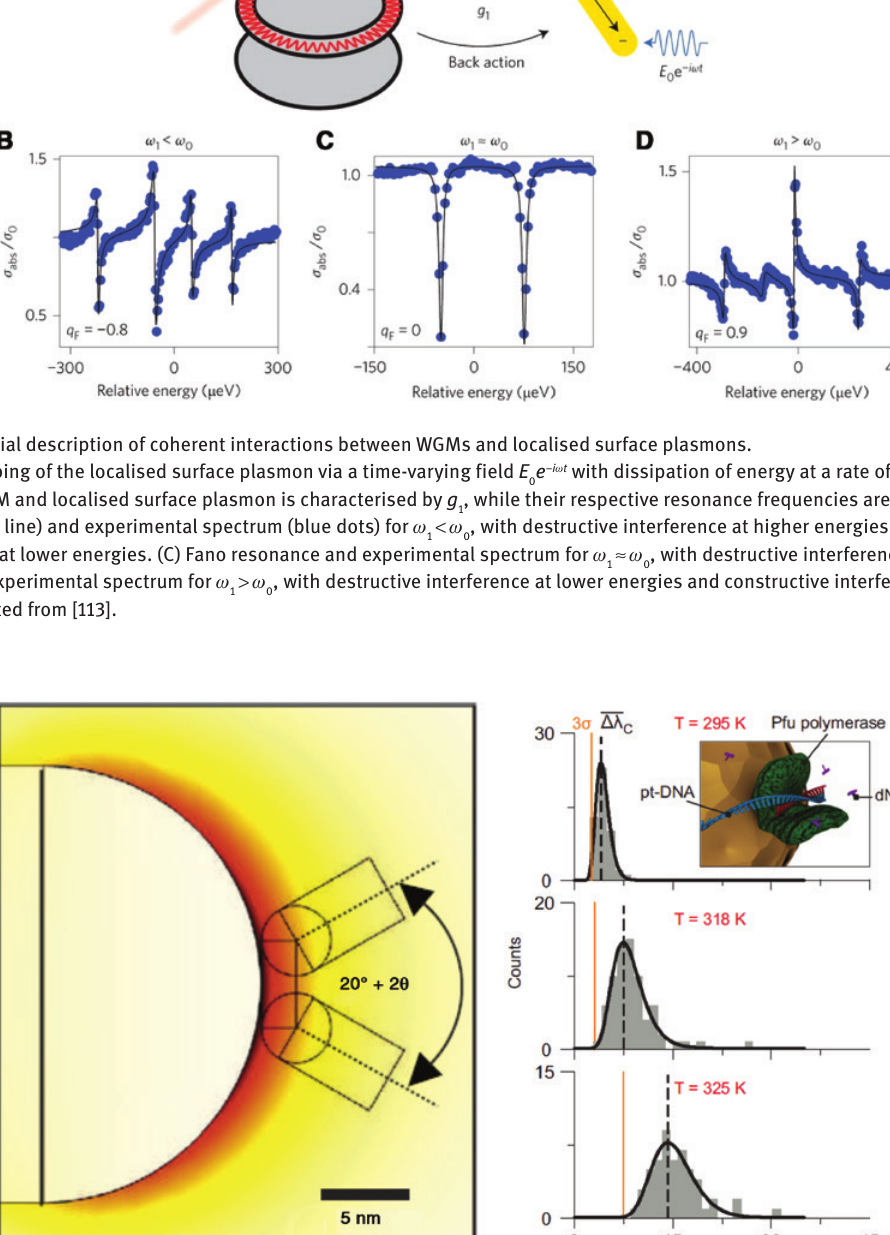
Figure 17: Histograms of the WGM wavelength shift for the opening and closing of the polymerase enzyme “hand”. The motion of the polymerase causes a change in the volume of the molecule overlapping with the near field of the WGM sensor, producing WGM shift signals with increasing amplitude as the temperature increases. Furthermore, this is elucidated by the motion of the polymerase which increases with the increase in the enzymatic activity associated with DNA synthesis (here, it is Pfu polymerase). Adapted from